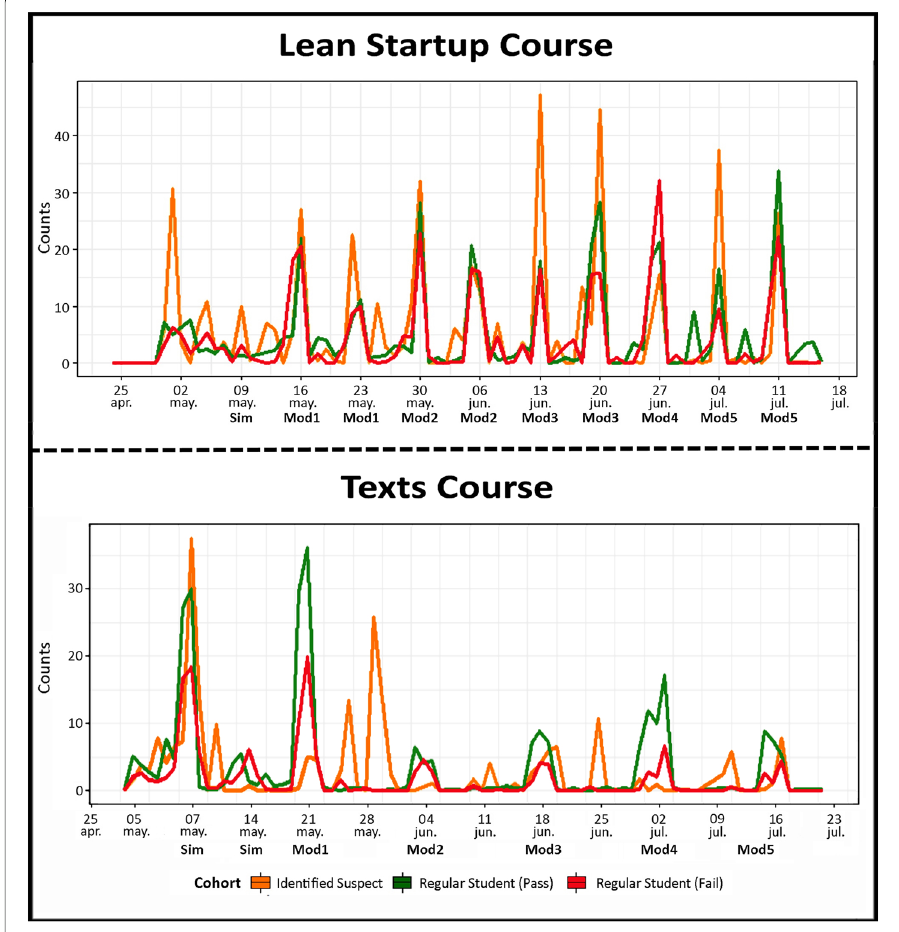
Fig. 5 Average number of interactions over time separated by